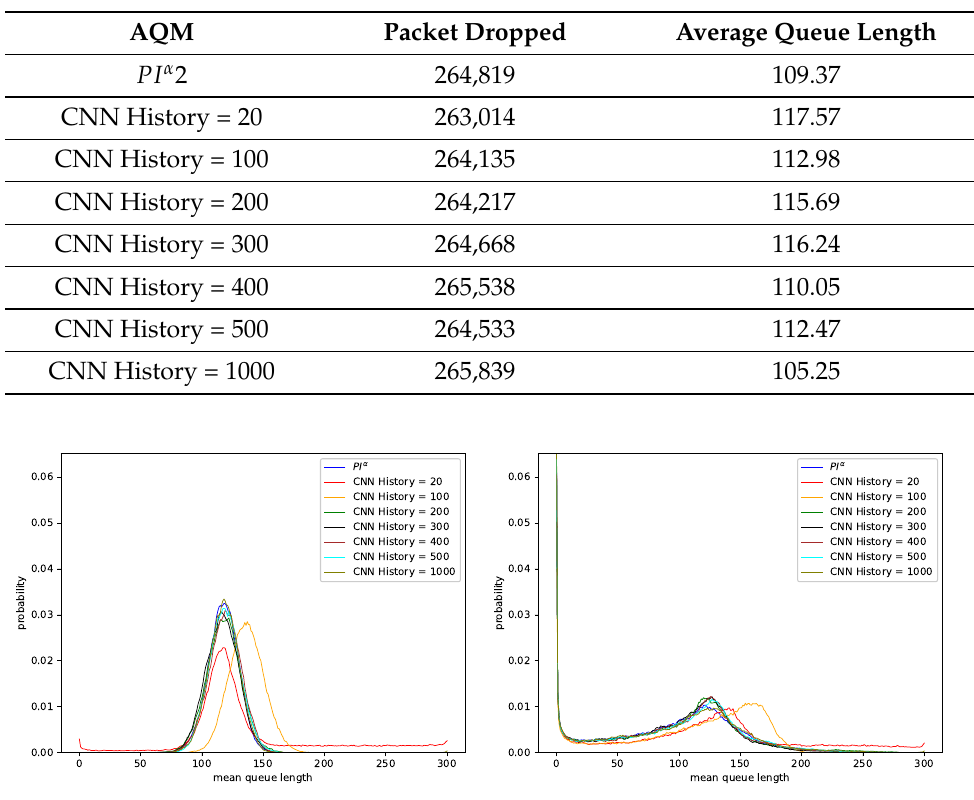
Figure 6. Distribution of queue length obtained for CNN model with the last layer activation function Sigmoid, trained using data regarding PI α 3 controller and parameters: K P = 0.0001, K I = 0.0004, α = − 0.6, H = 0.5 ( left ), H = 0.9 ( right ). Table 12. Detailed results of queue occupancy obtained for CNN model with the last layer activation function Sigmoid, trained using data regarding PI α 3 controller and parameters: K P = 0.0001, K I = 0.0004, α = − 0.6 and H =